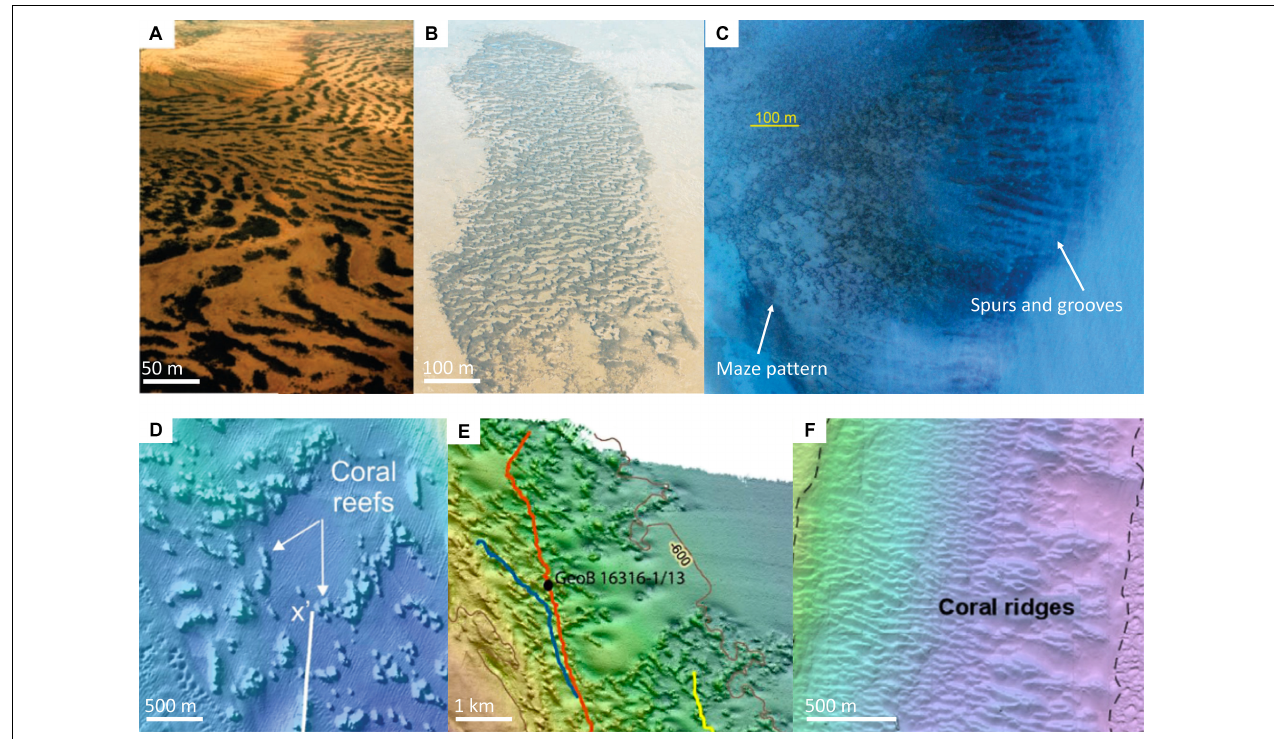
FIGURE 1 | Spatial patterns in natural systems. (A) Arid vegetation forming regular bands (adapted from Rietkerk et al., 2004. Reprinted with permission from AAAS). (B) Regular bands in a young mussel bed (adapted from van de Koppel et al., 2005. © 2005 by University of Chicago Press). (C) Maze (or “reticulate”) patterns, and a banded pattern called “spurs and grooves,” in tropical coral reefs (adapted from Schlager and Purkis, 2015. © 2014 The Authors. Sedimentology. © 2014 International Association of Sedimentologists). (D) Coral reefs in northern Norway, Hola reef, clustering into bands (adapted from Bøe et al., 2016. © 2016 The Geological Society of London). The white line with X’ is the start of a sub-bottom profile transect. (E) Coral ridges in the Gulf of Mexico, Campeche coral mound Province, forming a maze pattern (adapted from Hebbeln et al., 2014. © 2014 The Authors. CC Attribution 3.0 License). Depth contours are shown for 500 m (left) and 600 m (right). Colored lines denote (parts of) ROV dives. GeoB is a station number. (F) Coral ridges near Miami (adapted from Correa et al., 2012. © 2012. With permission from Elsevier). Dashed lines mark the area of the slope, which is covered in coral ridges. Miami Terrace is on the left and the base on the right. The terrace also features coral ridges, but the base is covered in sand dunes. Approximate scales are indicated.